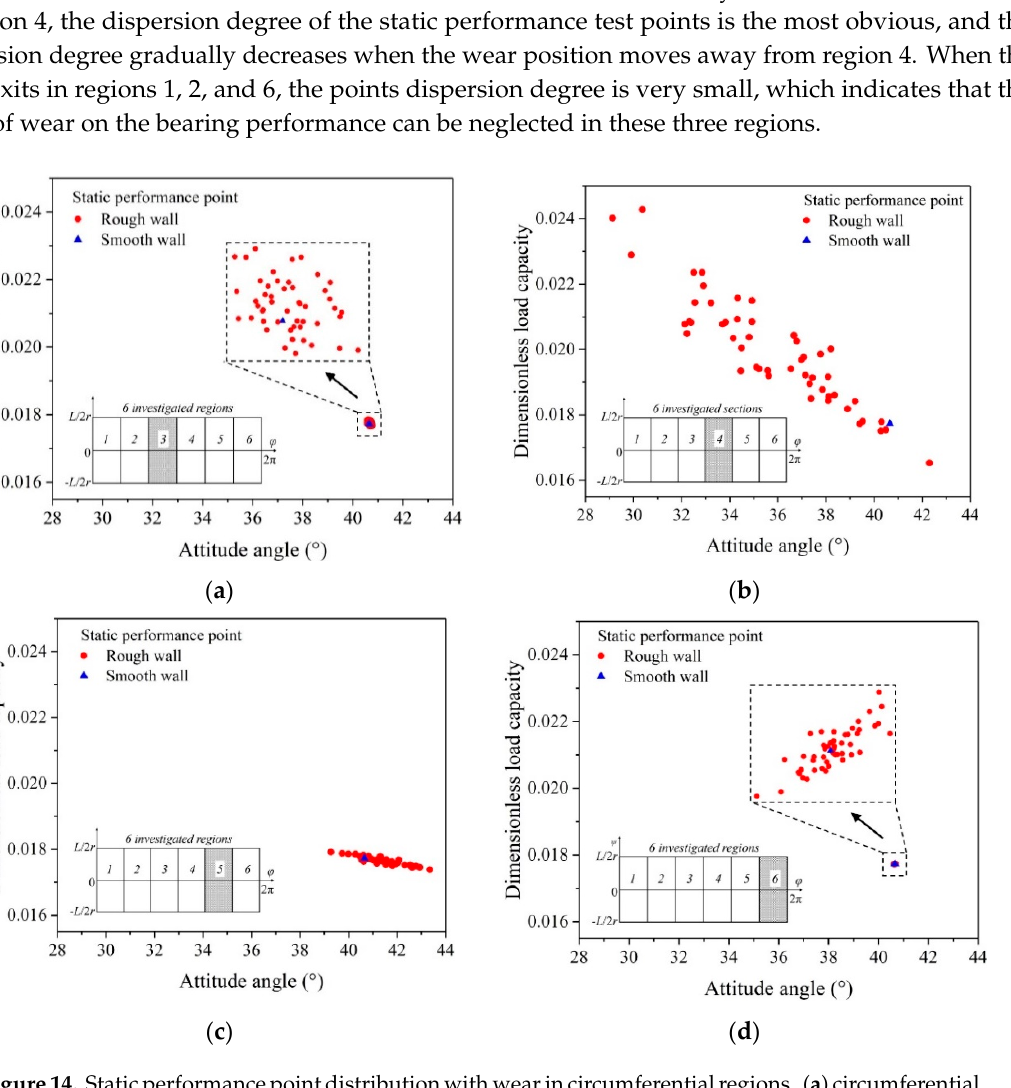
Figure 14. Static performance point distribution with wear in circumferential regions. ( a ) circumferential region 3. ( b ) circumferential region 4. ( c ) circumferential region 5. ( d ) circumferential region 6.